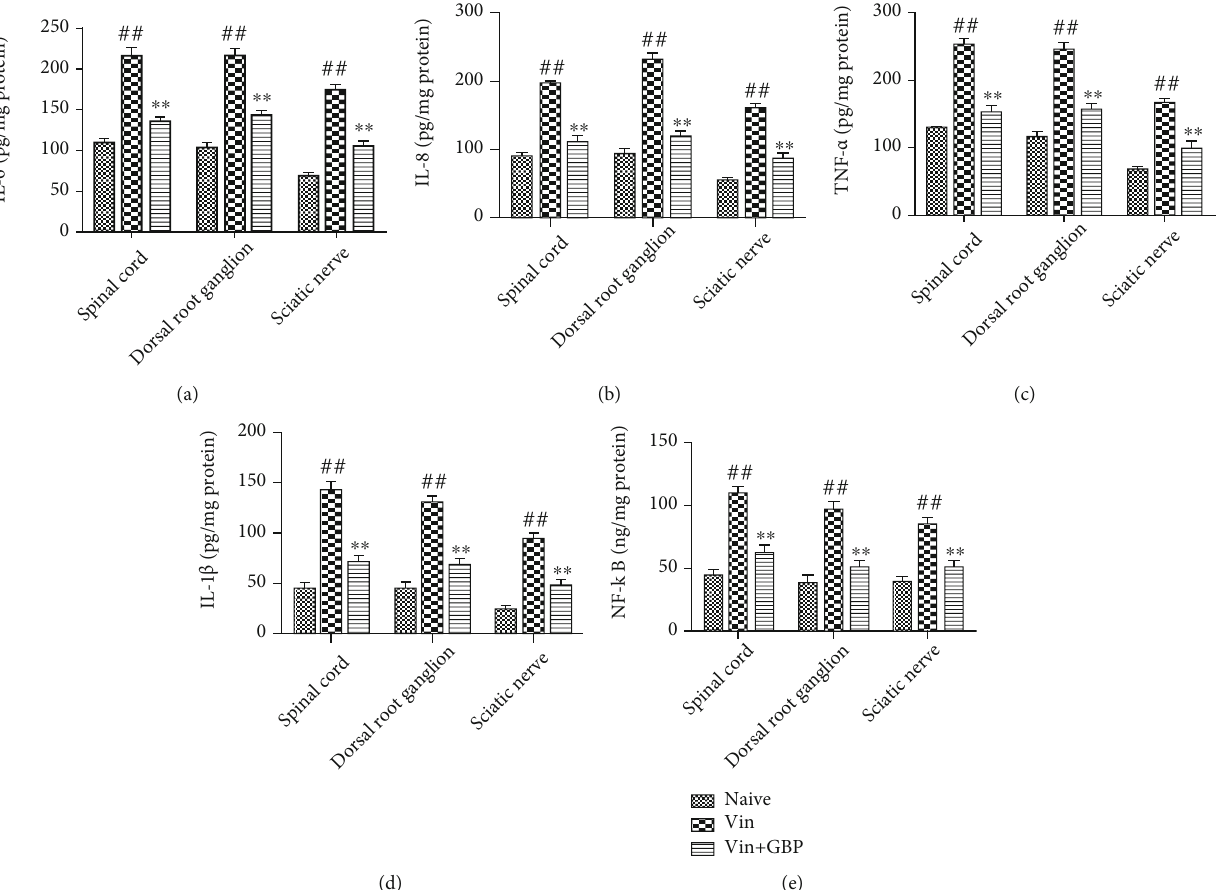
Figure 6: E ff ects of G. elata polysaccharide (GBP) administration on the levels of proin fl ammatory cytokines in Vin-induced neuropathic pain rats. After completion of the pain behavioral tests on day 21, levels of IL-6 (a), IL-8 (b), TNF- α (c), IL-1 β (d), and NF- κ B (e) in the sciatic nerve, spinal cord, and dorsal root ganglion (DRG) were measured. Data were expressed as the mean ± SD ( n = 8 for each group). # P < 0 : 01 : vs. naive group; ∗∗ P < 0 : 01 : vs. Vin group. One-way ANOVA followed by Bonferroni ’ s post hoc